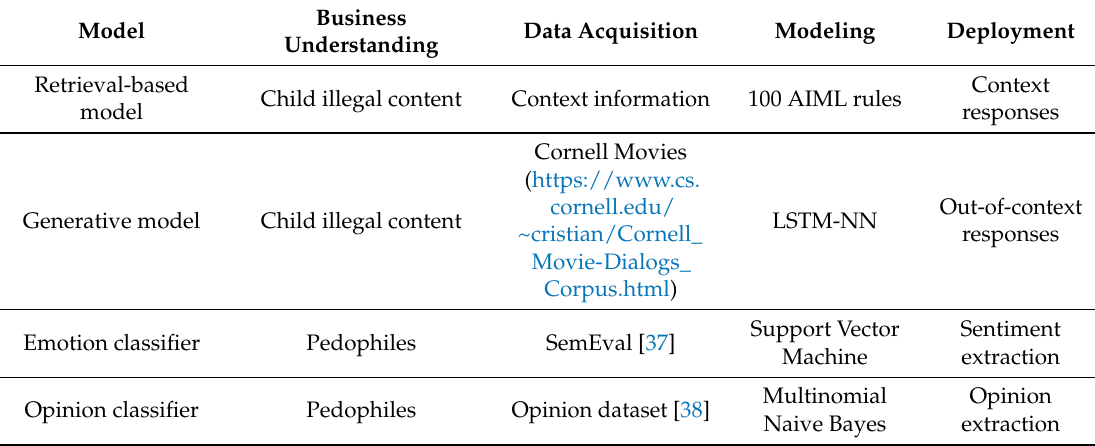
Table 3. Data science life cycle for C 3 -Sex